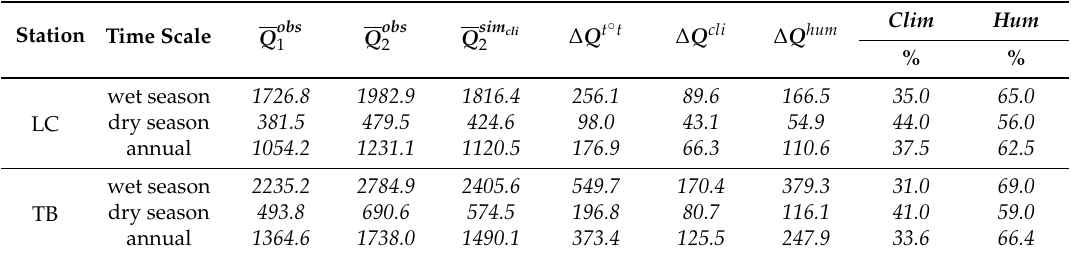
Table 5. Effects of human activities and climate change on the annual streamflow (mm) across catchments controlled by hydrological stations in the DRB (subscript 1: 1988–1993; subscript 2: 1994–2004).